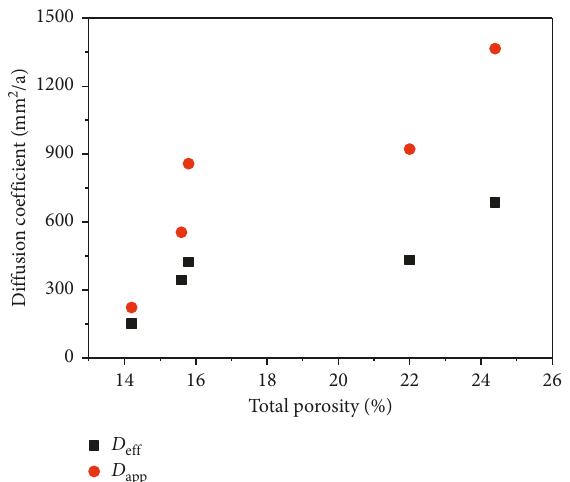
Figure 10: Relation between diffusion coefficient and the most probable pore size.